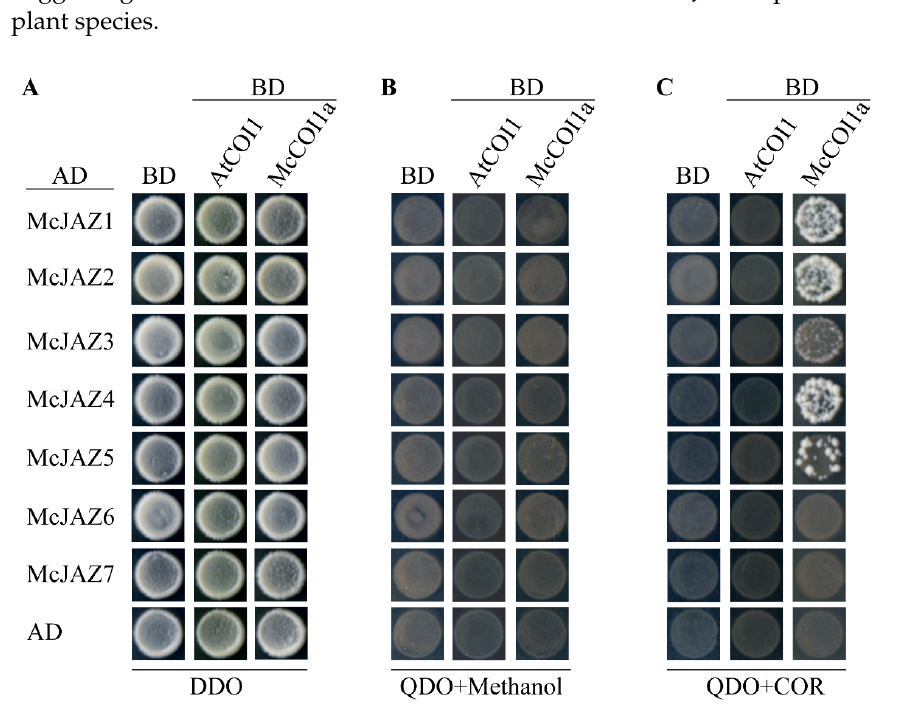
Figure 8. Yeast two - hybrid interactions between McJAZ proteins and McCOI1a or AtCOI1. The co-transformed yeast cells harboring the indicated plasmid combinations were inoculated in liquid medium SD/-Leu/-Trp (DDO), and then placed onto control medium SD/-Leu/-Trp (DDO) ( A ), selection medium SD/-Leu/-Trp/-His/-Ade (QDO) plus Methanol ( B ), and selection medium SD/-Leu/-Trp/-His/-Ade (QDO) containing 35 μ M coronatine (COR) ( C ). The empty pGADT7 (AD) and pGBKT7 (BD) were used as negative controls. These data represent three independent experiments, and representative photos were taken after 4 days of incubation at 30 °C.